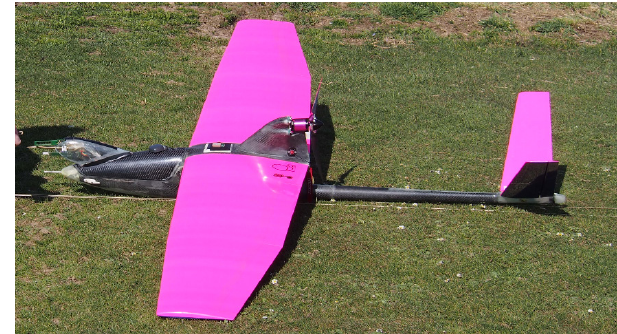
Figure 2. Research RPA MASC.